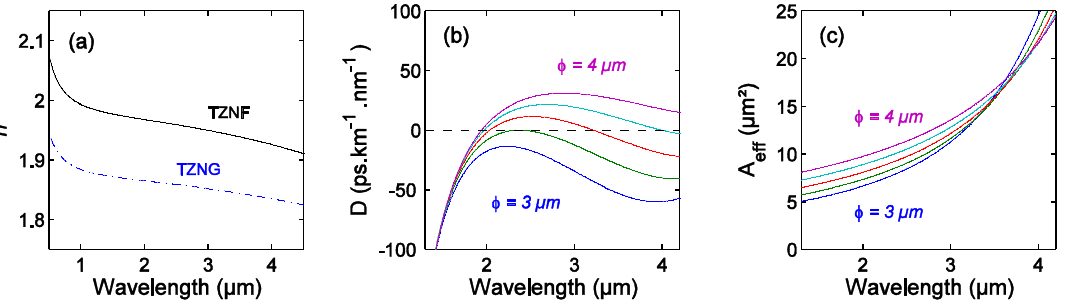
Figure 4. ( a ) Refractive index curves of both TZNF core and TZNG cladding glasses. ( b ) and ( c ) Wavelength-dependent curves of dispersion parameter D and effective mode area A eff of the fundamental guided mode in distinct step-index tellurite fibers with respective core diameters φ = 3, 3.25, 3.5, 3.75, and 4 μm.